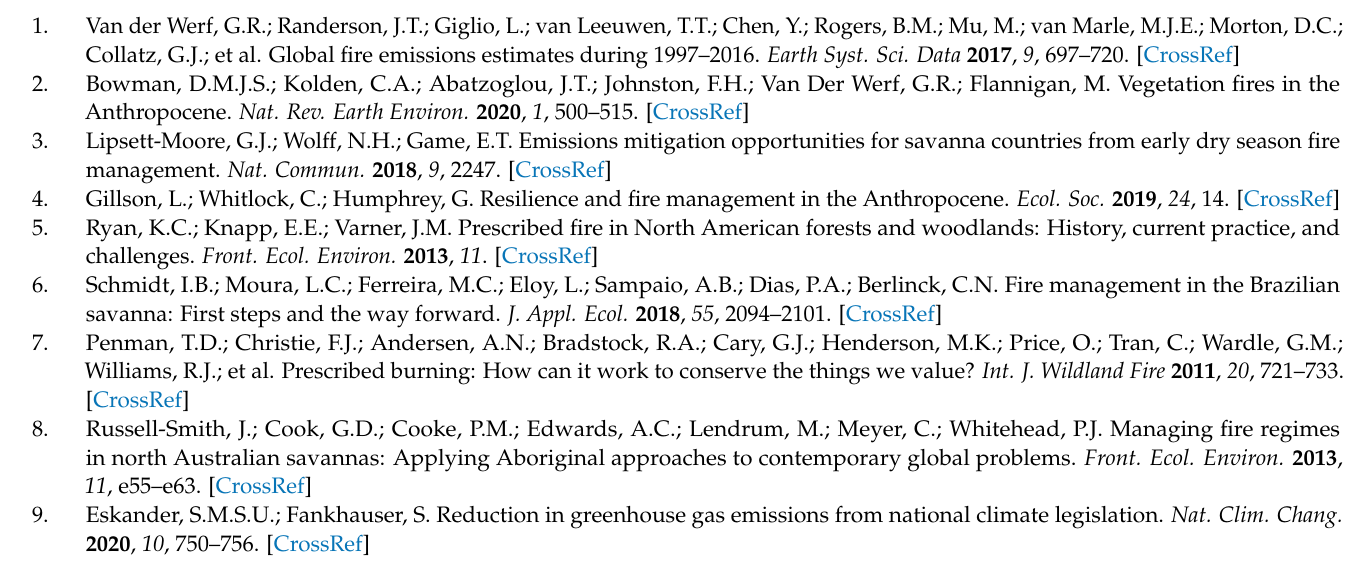
for each group of 1000 samples generated by bootstrapping approach. Values for Phases 1, 2 and 3 are sequentially depicted for each percentile from 10th to 90th. The medians are represented by black circles; Figure S4: Same as in Figure S3, but for FRP; Figure S5: Same as in Figure S3, but for PM2.5. Table S1: Relative difference (%) of the percentile 50th and 90th (in parenthesis) from annual accumulated burned area (BA) and total scar number (SN)(according to Figure 3) between NFP and ZFP, and between ZFP and IFM in Xerente (a) and Araguaia (b) for each fire season: management fire season (MFS) and wildfires season (WFS); Table S2: Relative difference (%) of the percentile 50th and 90th (in parenthesis) from burned area (BA) of large scars, fire radiative power (FRP) and pyrogenic emission (PM2.5) distribution (Figure 4) between NFP and 2 and between ZFP and 3 in Xerente (a) and Araguaia (b) for wildfires season (WFS); Table S3: The proportion of pixels (i.e., area) in each fire recurrence class: zero, low ( ≤ 0.6 fire occurrence per year) and high (>0.6 fire occurrence per year) in Xerente (a) and Araguaia (b), according to Figure 5; Table S4: Modal month in each class for all three phases on Xerente (a) and Araguaia (b), according to Figure